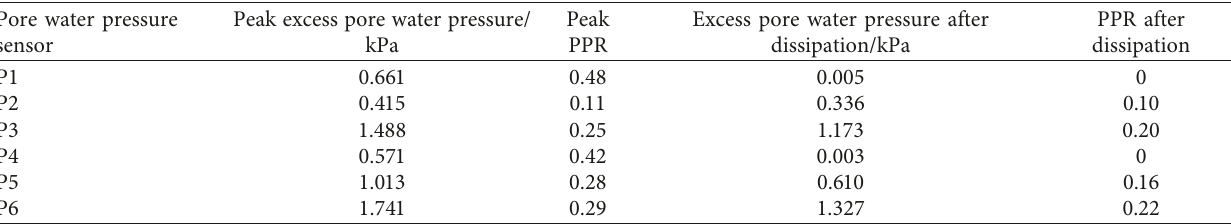
Figure 16: Data from simultaneous fracturing blast vibration test. (a) Time course curve of excess pore water pressure in sand on one side of the ordinary pile. (b) Time course curve of excess pore water pressure in sand on one side of the drainage rigid pile. Table 2: Excess pore water pressure and PPR of each measurement